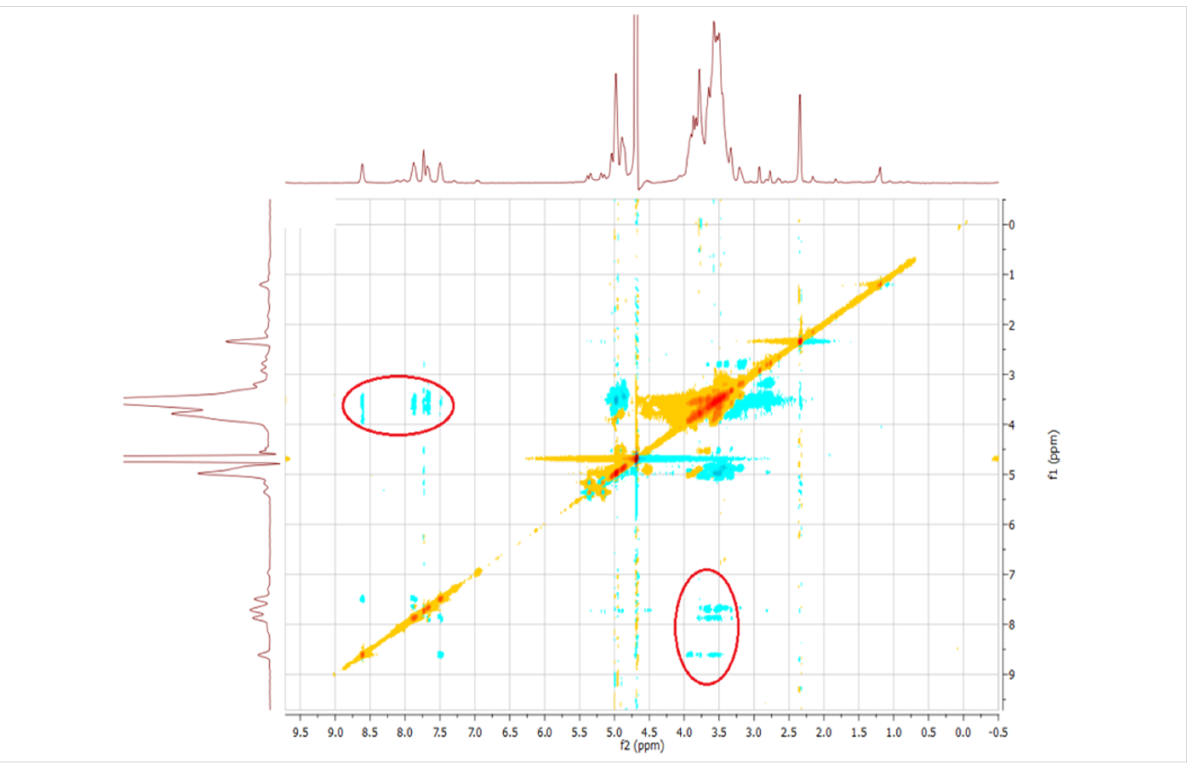
Figure 1: 1 H NMR-ROESY spectrum of the modified CD 3 .